Question: What style of plot is this figure drawn as?
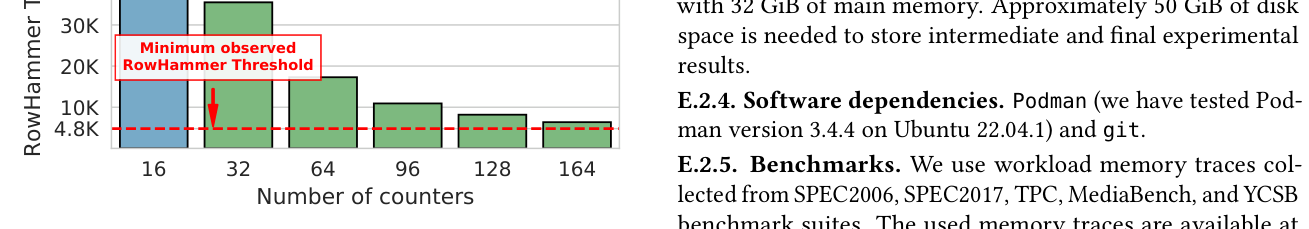
Answer: bar